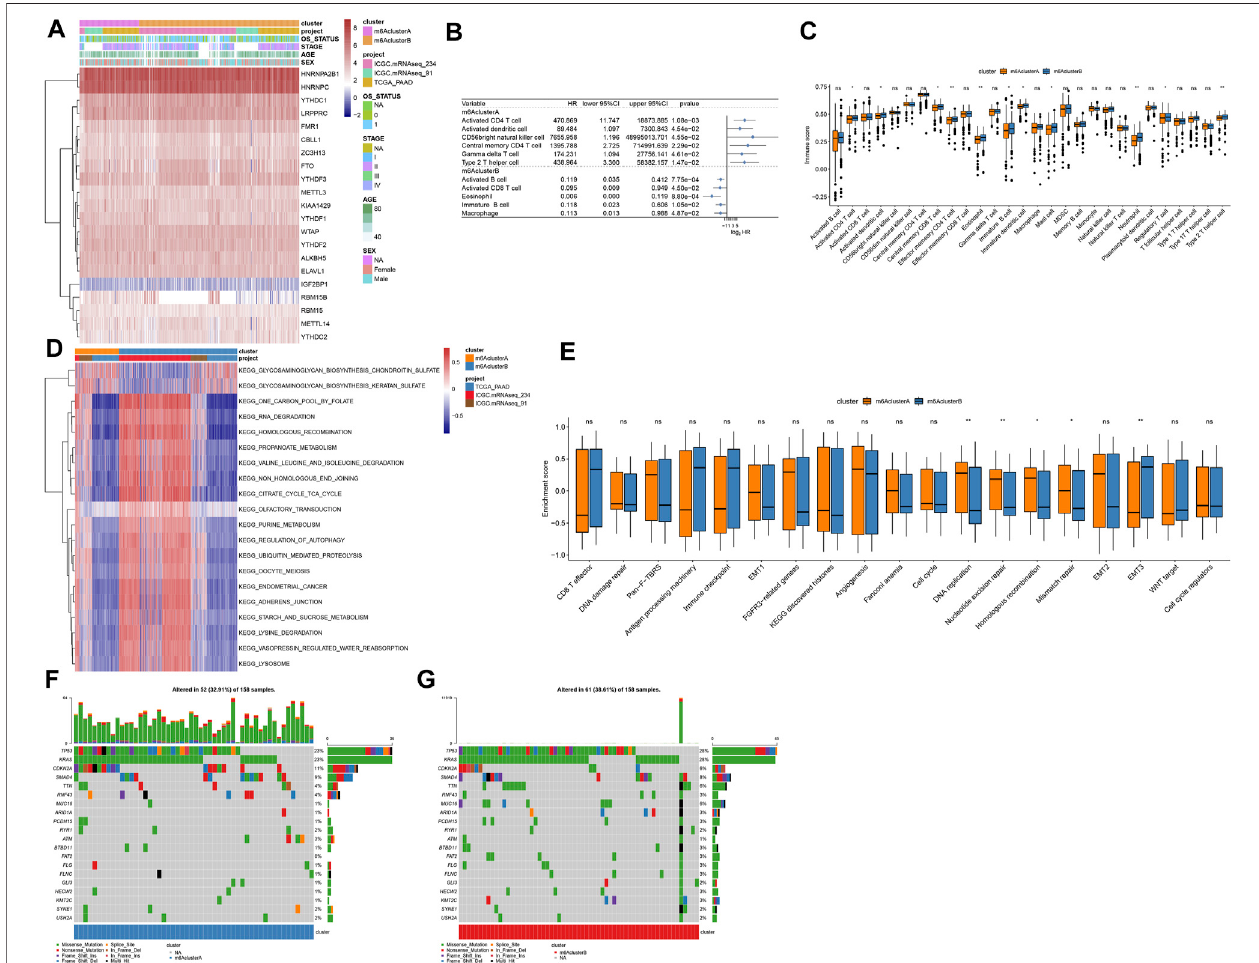
FIGURE 3| Two m 6 A methylation modi fi cation patterns with distinct immune cell in fi ltration, biological functions, and genetic mutation. (A) Heatmap of expression patternsofm 6 Aregulatorsinm 6 Aclusters(clusterAandB),OSstatus,stage,age,andsex. (B) Associationsbetweenimmunecellsandprognosesofpancreaticcancer. HR: hazard ratio and CI: con fi dence interval. (C) Box plot of the in fi ltration levels of immune cells in two m 6 A clusters. Ns: not signi fi cant; * p < 0.05; ** p < 0.01. (D) GSVA enrichment analysis for the activation status of biological pathways in two m 6 A clusters. (E) Box plots of the enrichment scores of key biological processes in two m 6 A clusters. (F) The somatic mutation landscape of samples in m 6 A cluster A. (G) The somatic mutation landscape of samples in m 6 A cluster